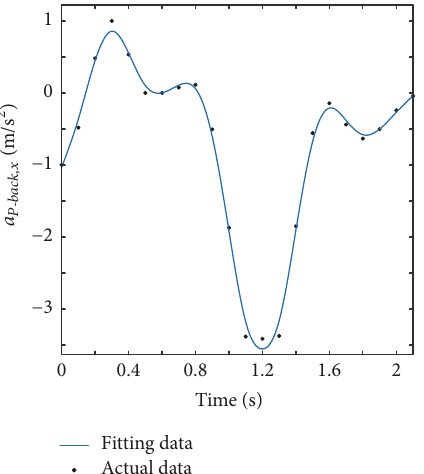
Figure 19: Acceleration curve of P-back in the positive direction of X-axis with